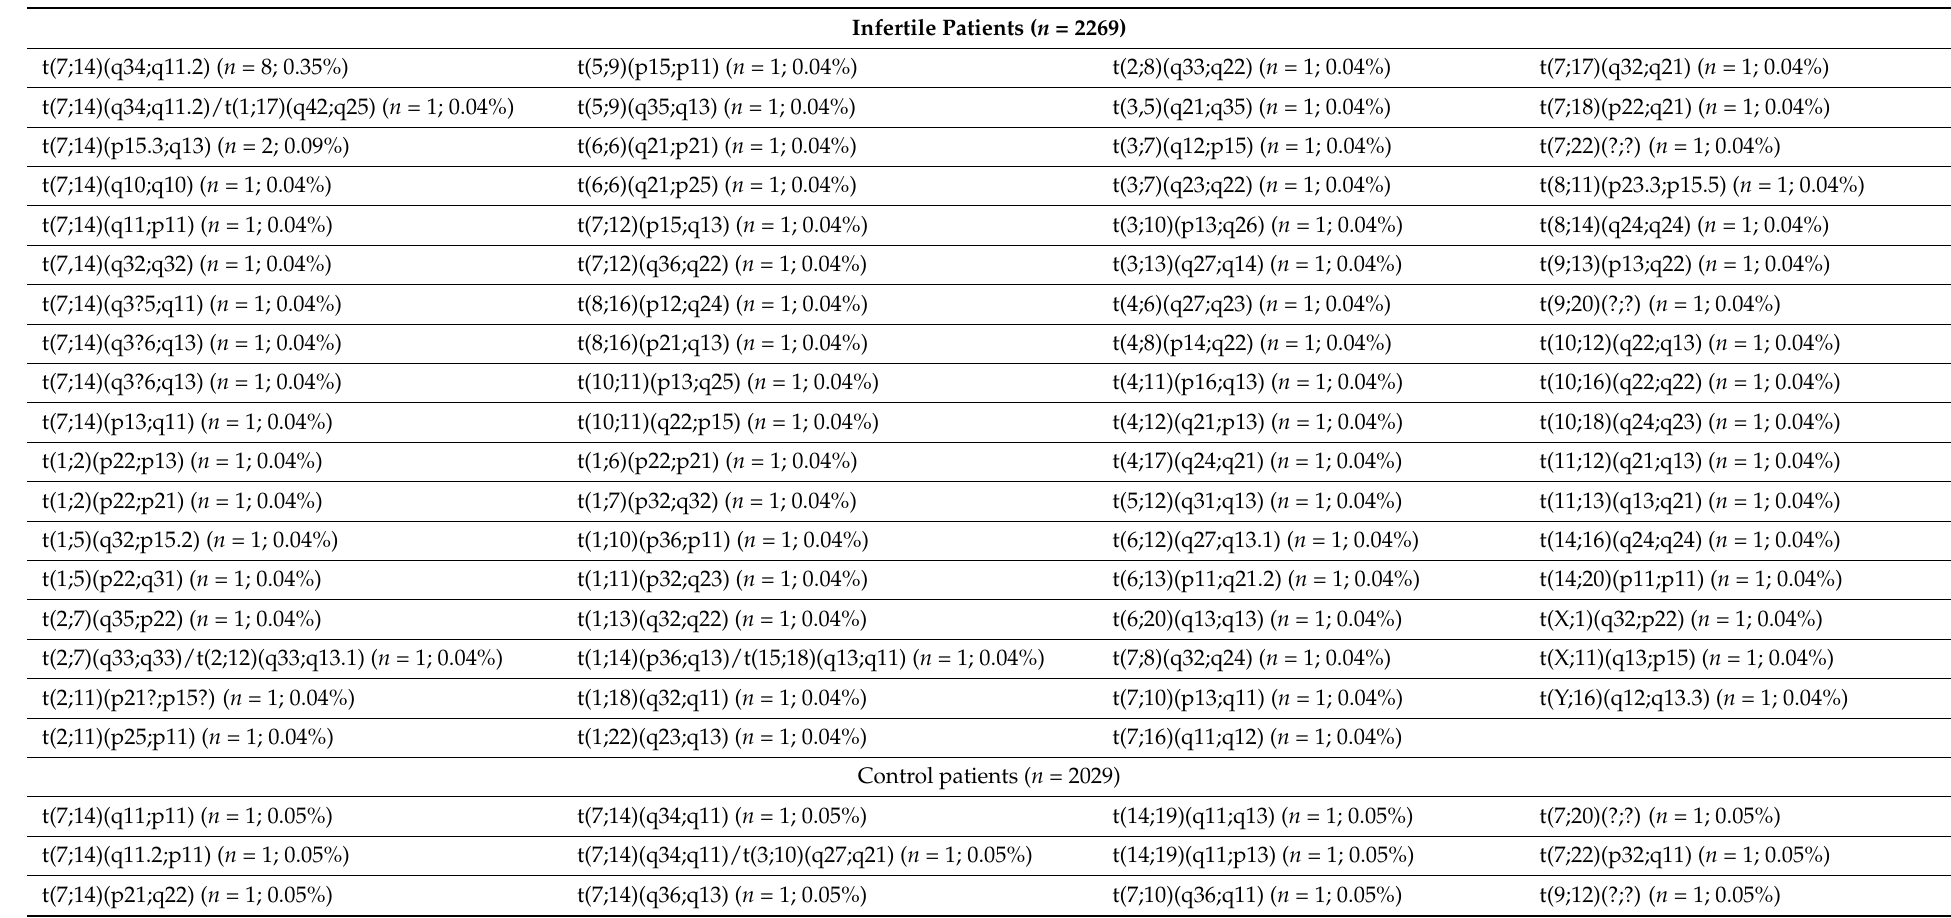
Table 3. Types of SCTs in infertile and control